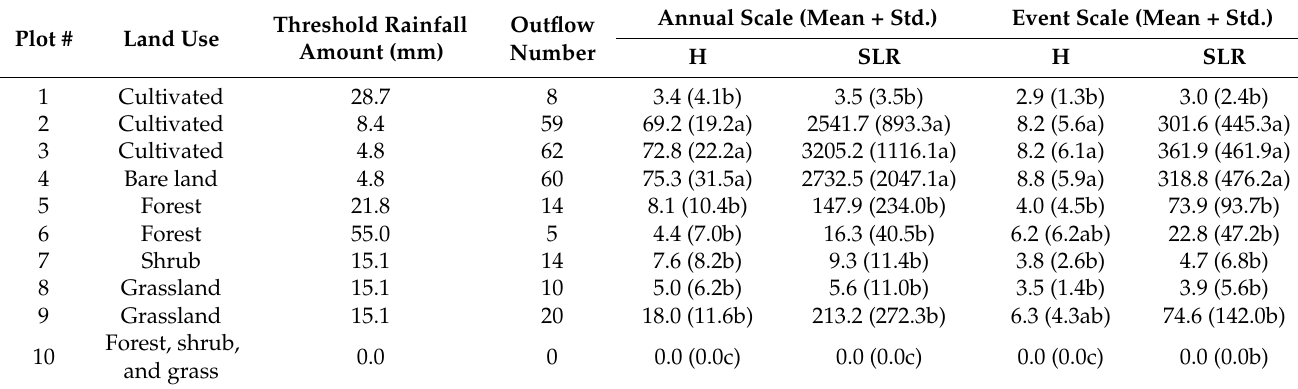
Table 3. Characteristics of runoff depth (H) and soil loss rate (SLR) on the 10 runoff plots at annual and event scales in